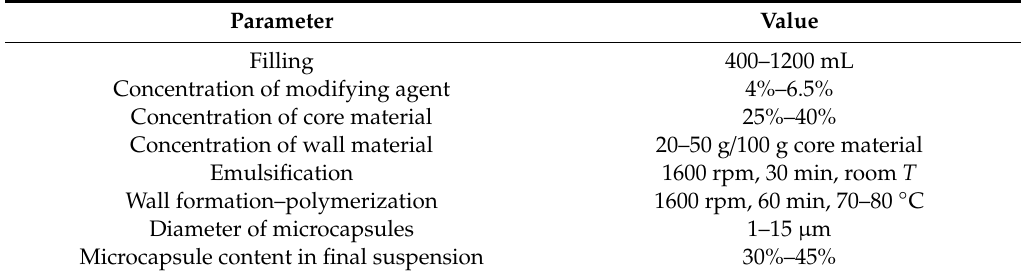
Table 5. Main process parameters of citronella oil microencapsulation in situ polymerization.